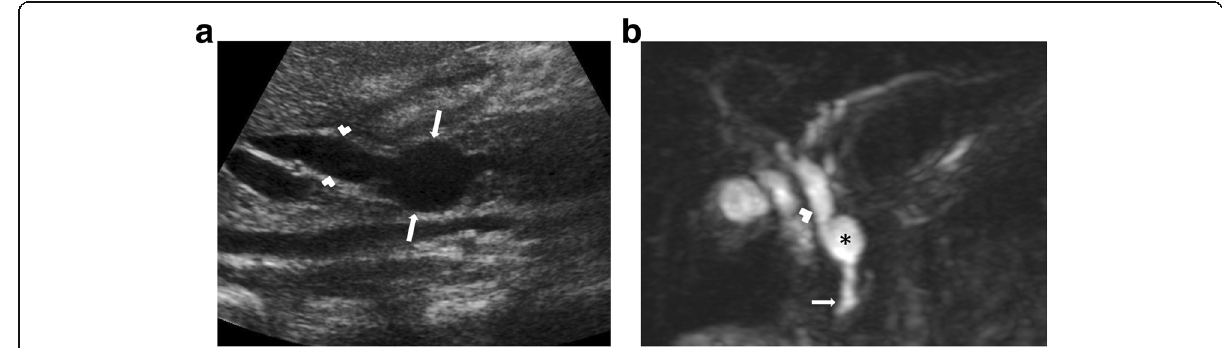
Fig 9 An 11-year-old female patient with newly diagnosed Hodgkin lymphoma underwent an initial US exam. a US image reveals choledochocele (long arrows) that involves the intramural segment of the distal common bile duct (arrowheads). b Coronal plane MRCP MIP image shows choledochocele (asterisk), common bile duct (arrowhead), and duodenum (arrow)